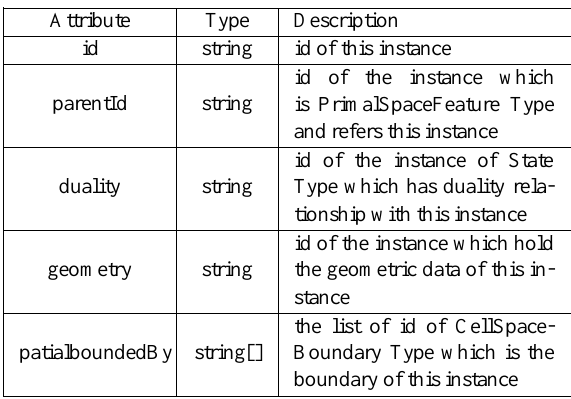
Figure 6. Overall Structure of InFactory